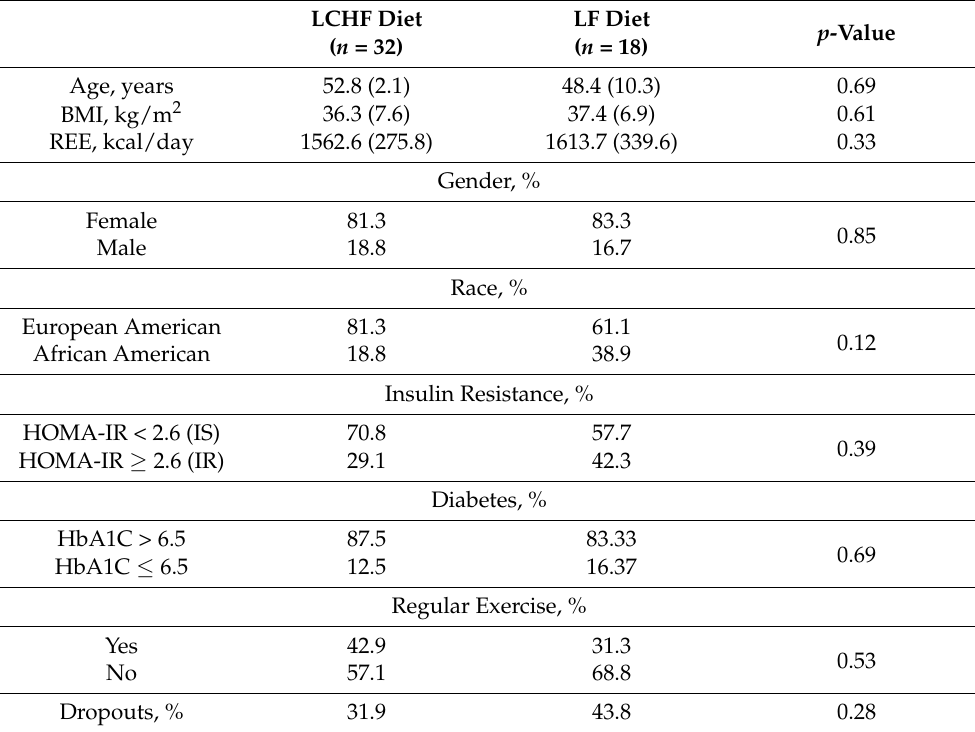
Table 1. Baseline Characteristics of Participants by Intervention ( n = 50).